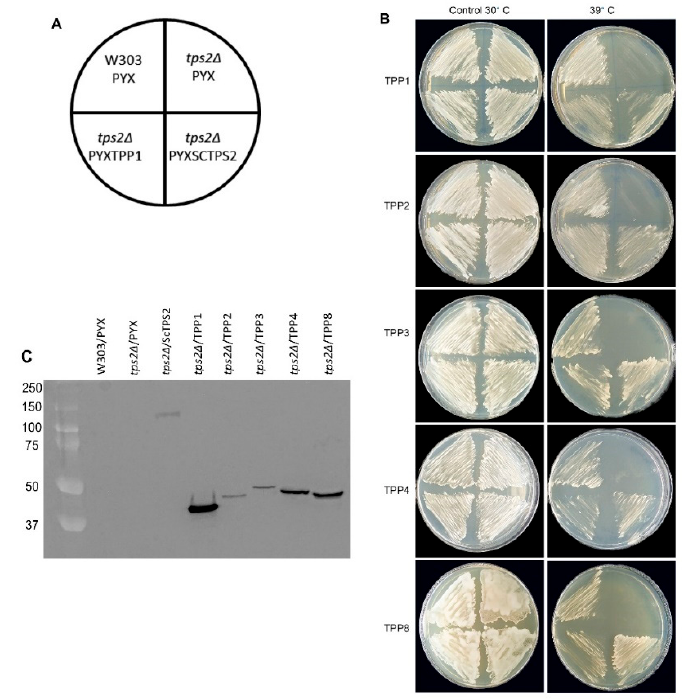
Figure 5. All tomato TPP isoforms tested display heterologous trehalose-6-P phosphatase (TPP). ( A ) Layout of growth plates. ( B ) Complementation of the yeast Δ tps2 growth defect at 39 °C. Growth at 30 °C served as a control. ( C ) Verification of protein expression in the individual yeast strains by immunoblotting using an anti-HA antibody. The experiment has been repeated three times with three independent plates each, yielding similar results. Representative images are shown here.